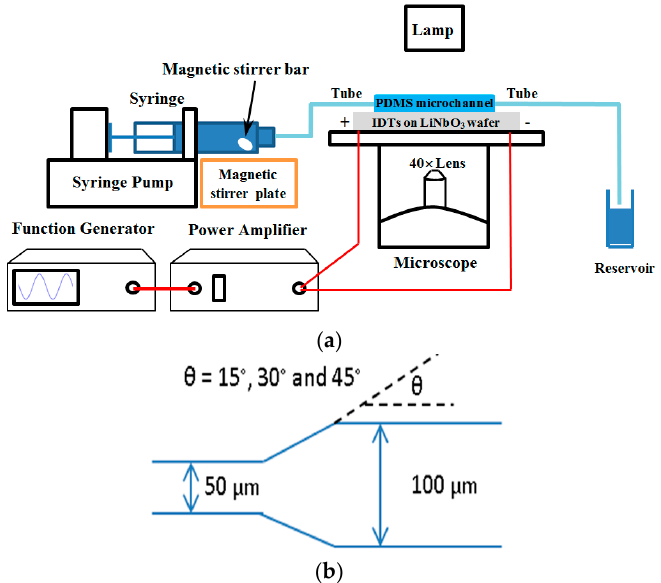
Figure 1. ( a ) Schematic diagram of the experimental setup; and ( b ) the geometry of microchannel with the various constriction angles.